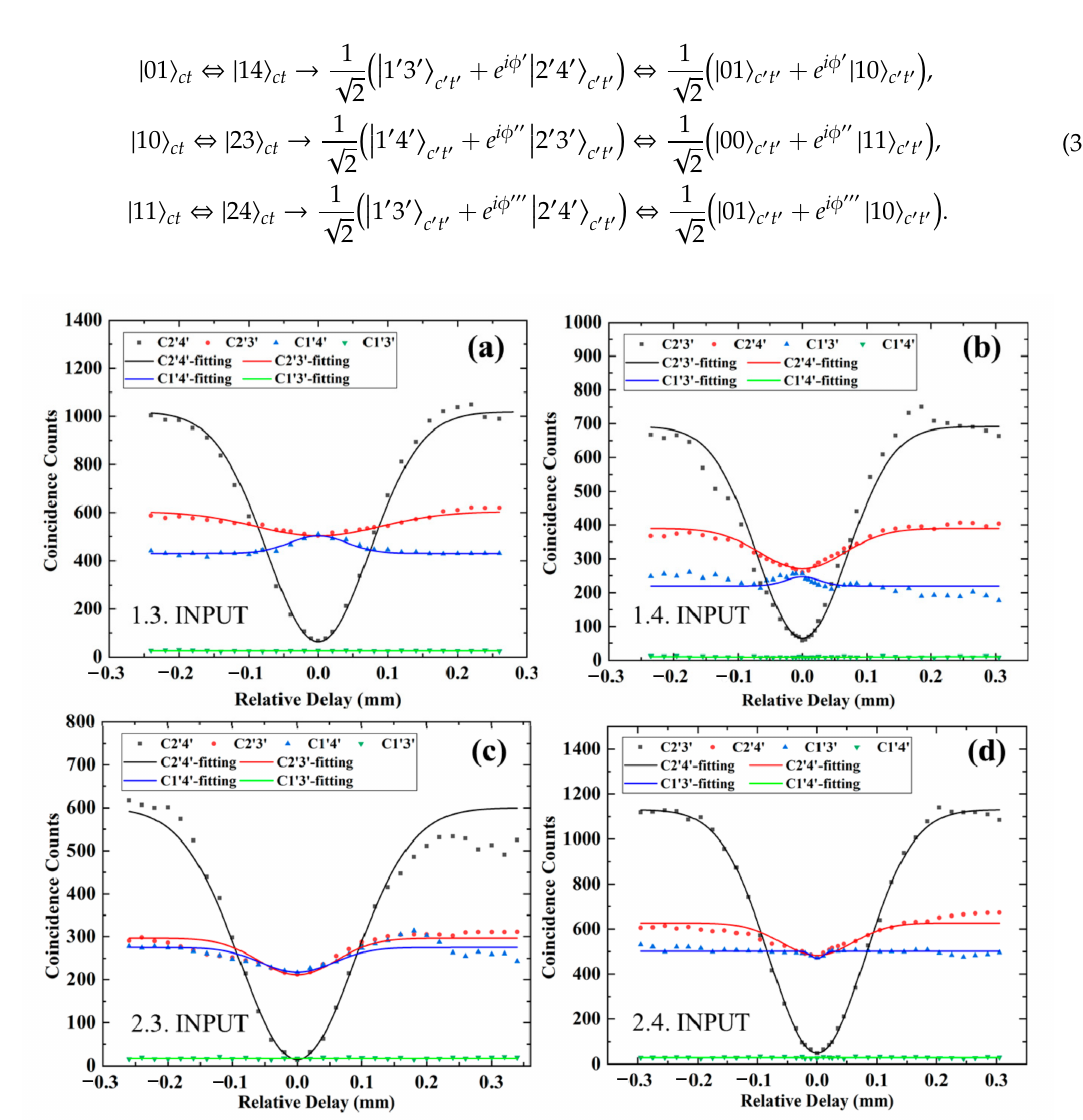
Figure 5. Coincidence counts in 30 s of post-selected output-photon combinations x (cid:48) y (cid:48) denoted as Cx (cid:48) y (cid:48) for di ff erent input-photon combinations xy denoted as x.y. INPUT as a function of the relative delay of photons input in x and y ports: ( a ) input (1,3); ( b ) input (1,4); ( c ) input (2,3); ( d ) input (2,4). From the interference curve with a deep dip, the HOM interference visibilities are ( a ) 98.5 ± 1.2%, ( b ) 97.8 ± 1.8%, ( c ) 98.2 ± 1.8%, ( d ) 99.5 ± 0.5%,